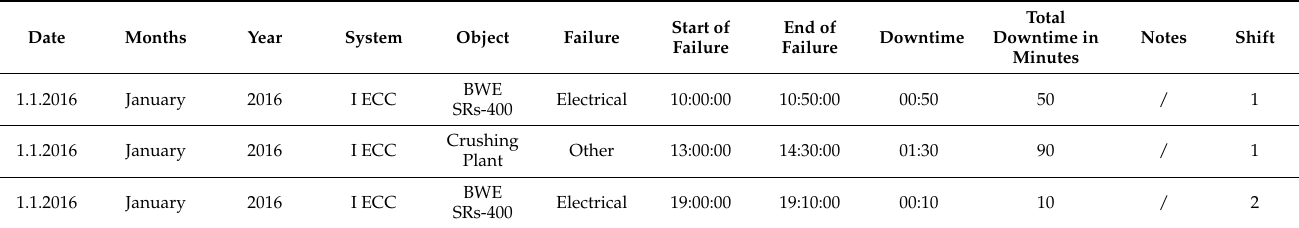
Table 2. Database form (a part of database).